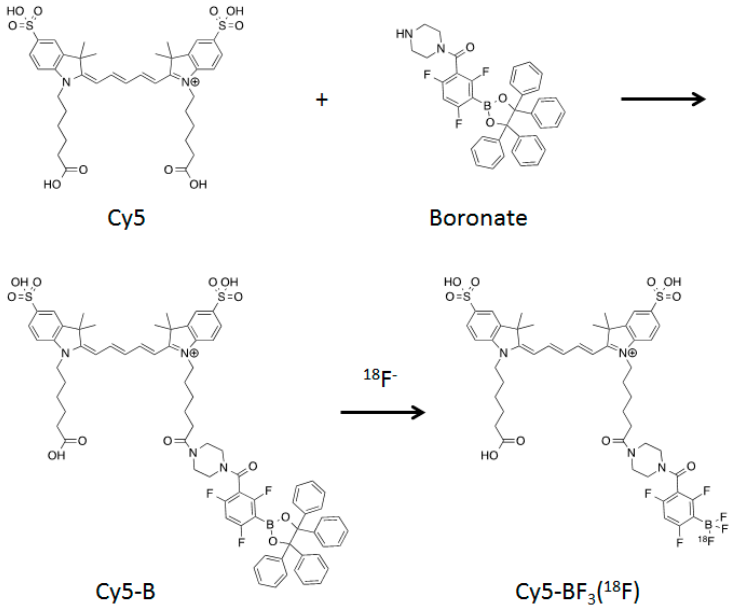
Figure 1. Synthetic scheme for a Cy5-BF 3 ( 18 F). 18 F-labeled conjugate for PET/NIRF dual-modal imaging.